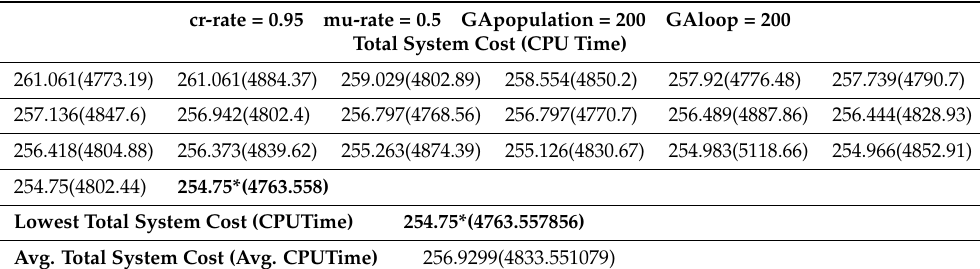
Table 25. The total system costs of 20 simulation runs obtained by ENUM–MGA for the n -stage q /2-out-of- q system.